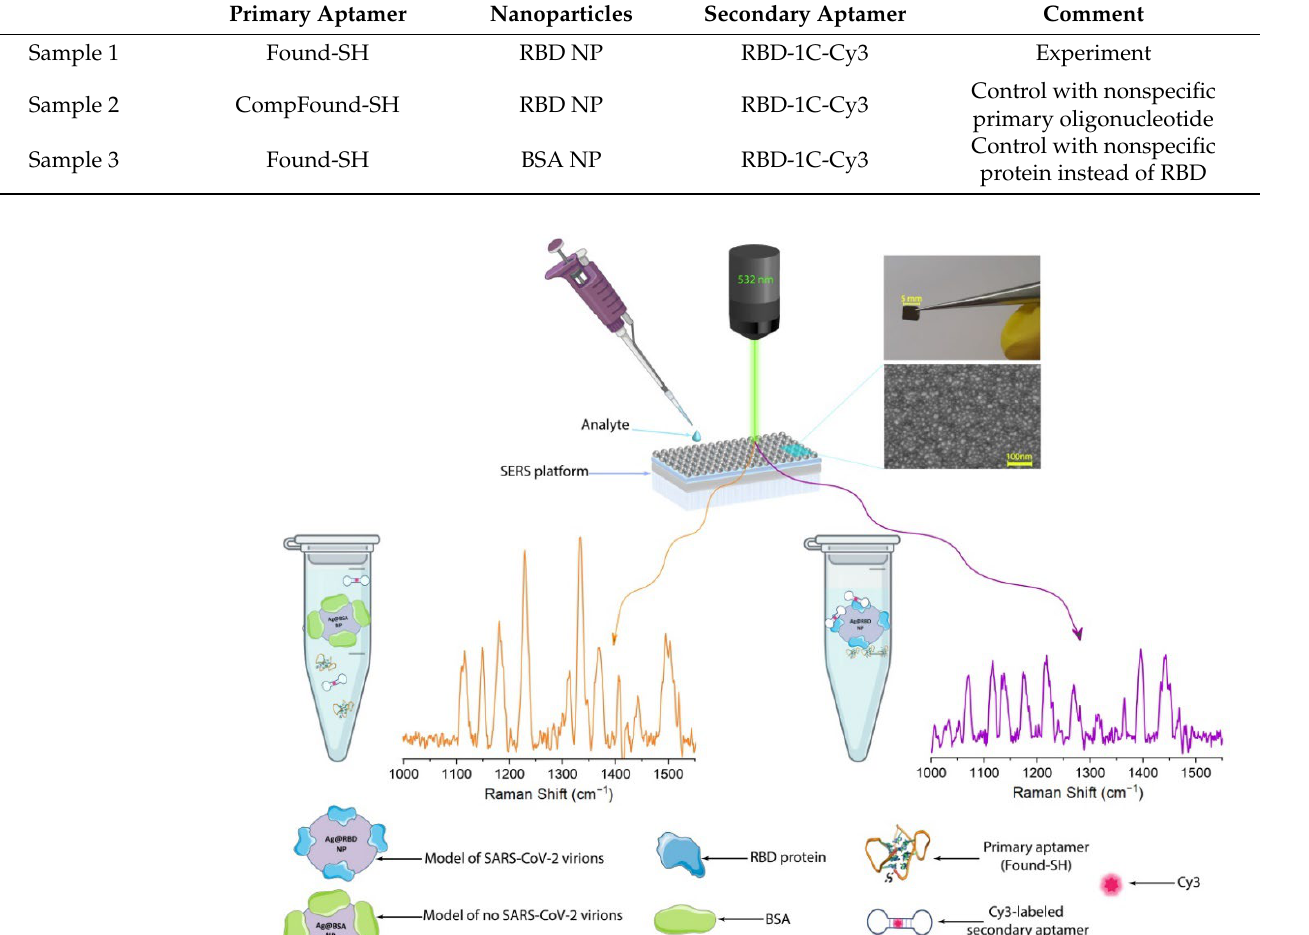
Table 1. Combinations of aptamers and protein-coated nanoparticles studied.